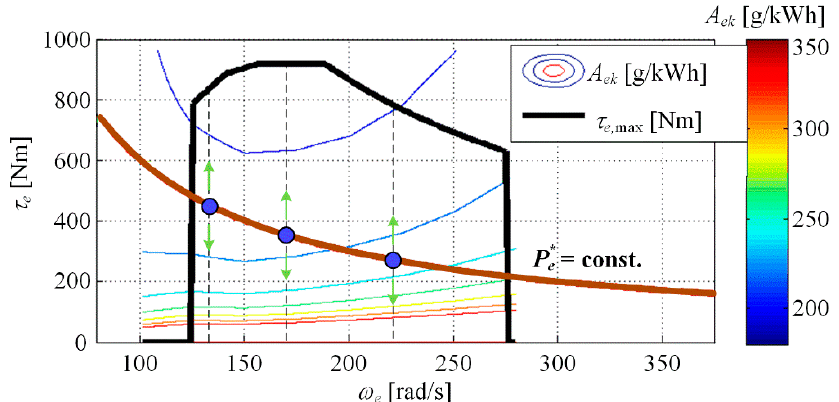
Figure 11. Engine specific fuel consumption map including illustration of ECMS-based operating point search.